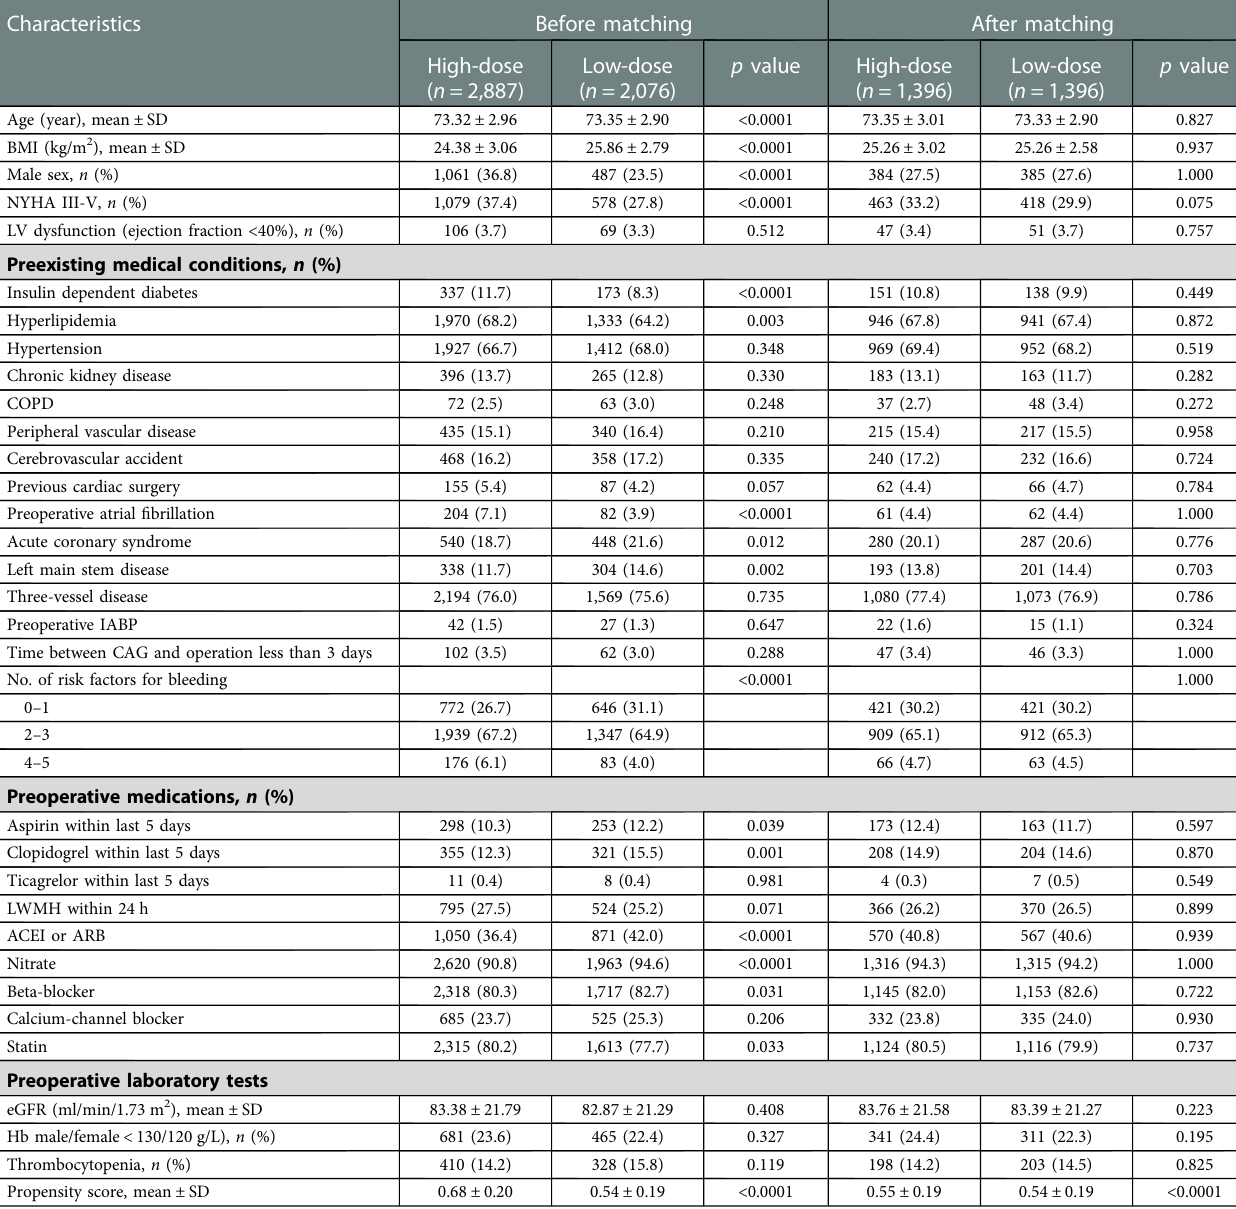
TABLE 2 Characteristics of elderly patients in the high-dose and low-dose TA group.